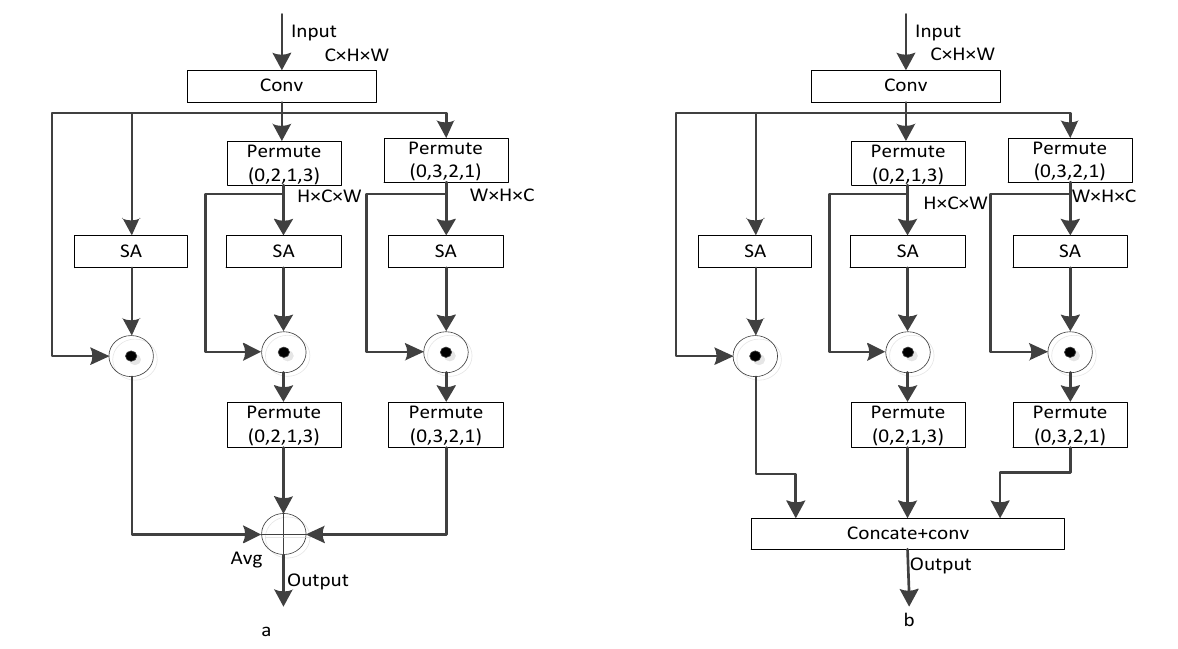
Figure 5. Comparisons of different triplet attention modules: ( a ) Default triplet attention (TA) module. ( b ) Concatenation-based and convolutional triplet attention module (C_TA) (ours). The feature maps are denoted by feature dimensions, e.g., C × H × W denotes a feature map with C channels, height H, and width W. Conv denotes general convolution operation. Permute denotes rotation operation for rotating dimensions. Avg denotes mean operation. ⊙ denotes element-wise multiplication and ⊕ denotes element-wise addition. SA denotes spatial attention.